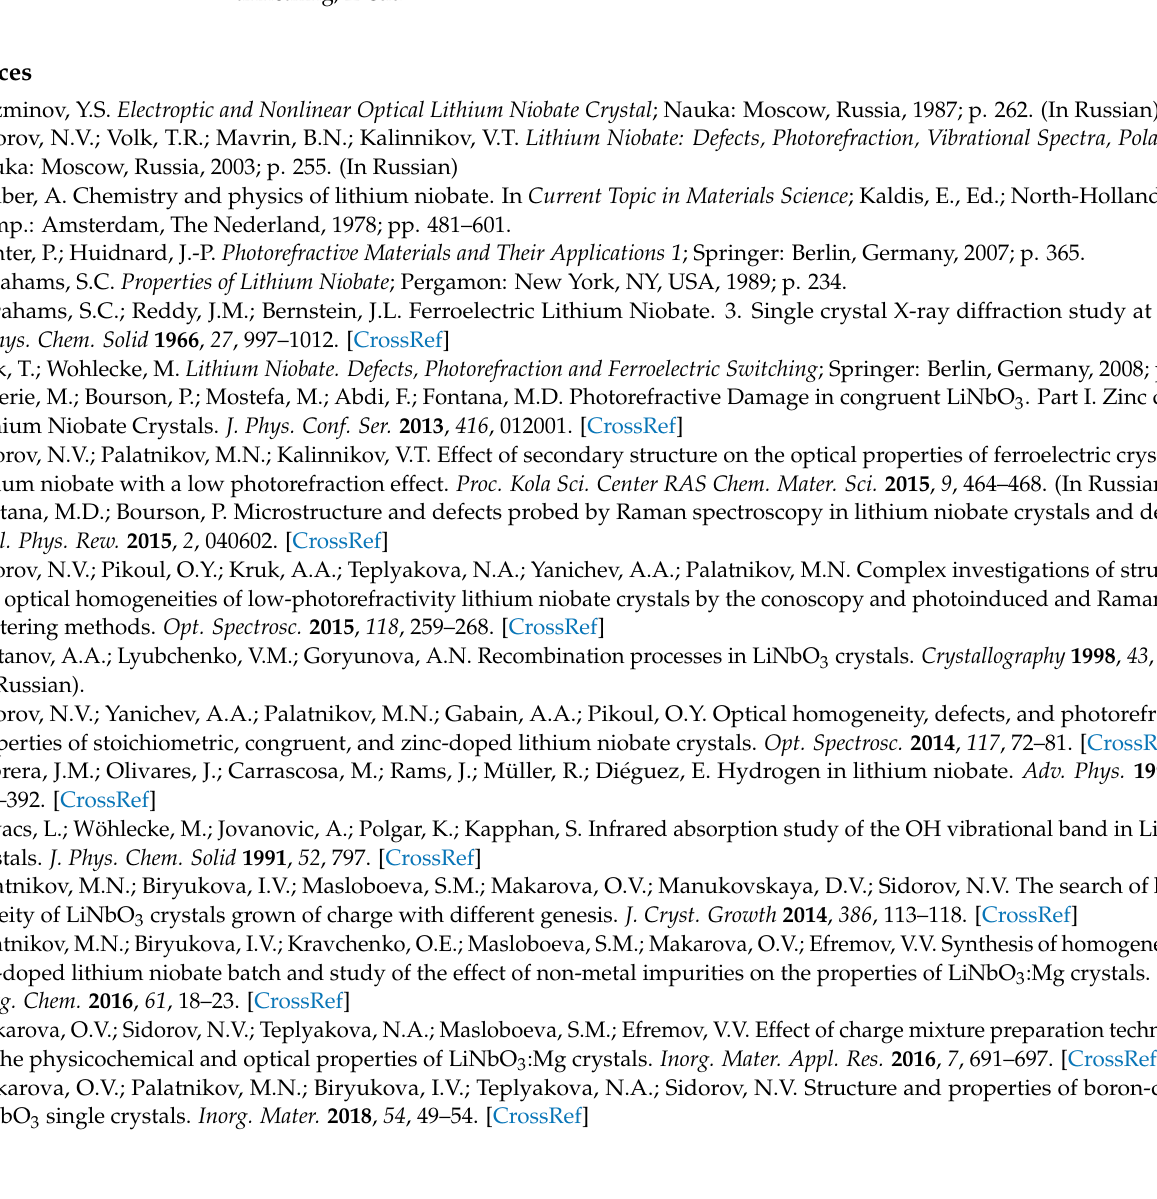
Figure A12. NANO-R ATF image of a hexagonal microdomain in a LiNbO 3 :Mg crystal (joint solid-phase synthesis, [MgO] ≈ 5.59 mol% in the melt), after the high-temperature electrodiffusion annealing, Z-cut.